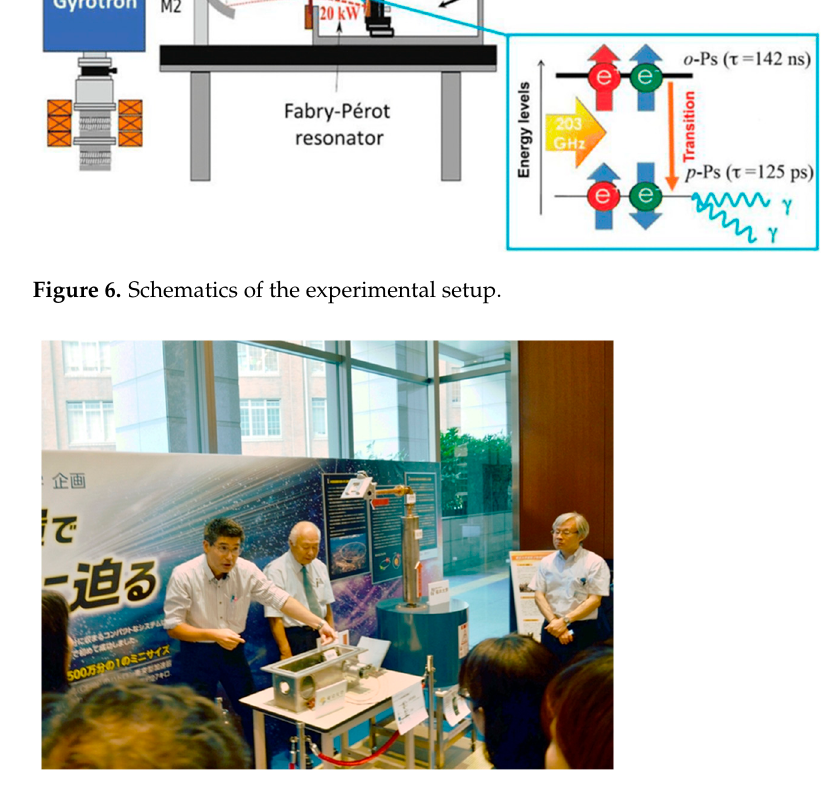
Figure 6. Schematics of the experimental setup.